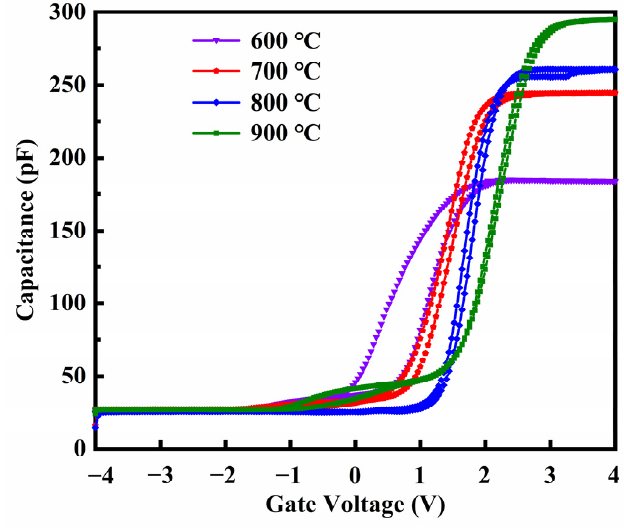
Figure 11. Capacitance–Voltage characteristics of MOS capacitors. Table 1. Parameters extracted from C-V curves.